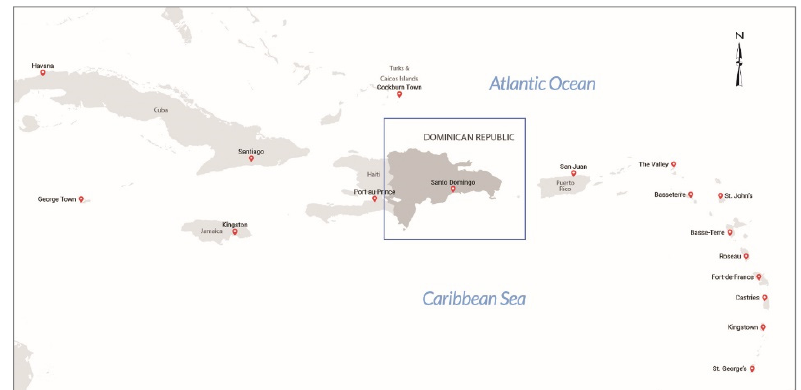
Figure 1. Map of the Dominican Republic in the Caribbean region. Source: National Geological Survey.